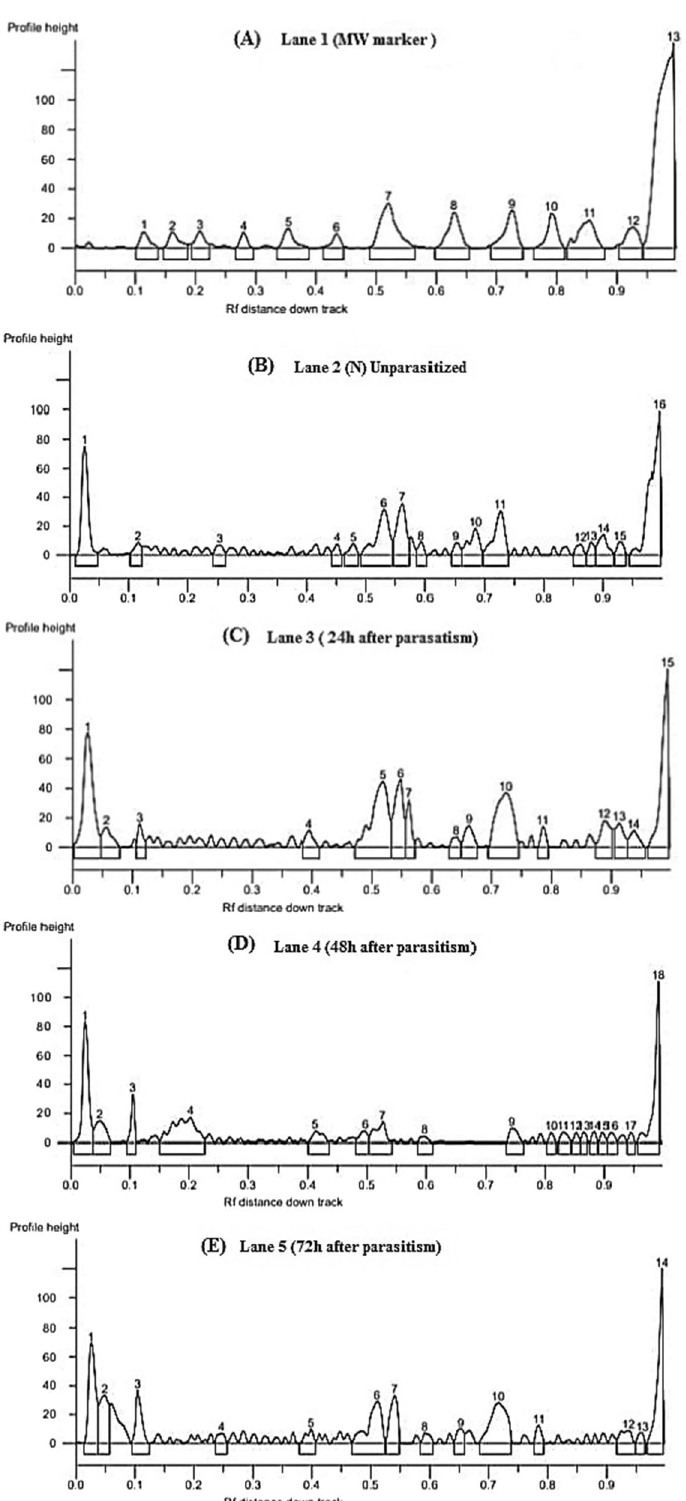
Fig. 6 Changes in the Retardation factor (RF) of separated hemolymph protein bands of full grown larval instar Corcyra cephalonica of both Unparasitized and Bracon hebetor Parasitized larvae through natural envenomation of at Successive period of parasitism. A lane 1 (MW Marker of protein); B lane 2 (Unparasitized hemolymph of C. cephalonica larvae); C lane 3 (hemolymph after 24h post parasitism); D lane 4 (hemolymph after 48h post parasitism); E lane 5 (hemolymph after 72h post